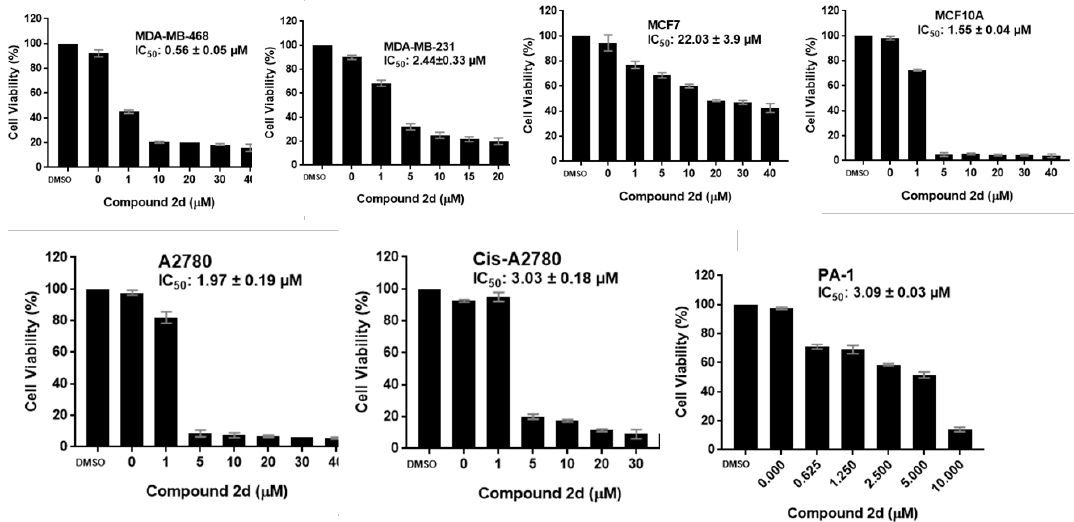
Figure 7. The cell viability (%) relative to untreated control cells of selected breast and ovarian cancer cell lines and breast normal (MCF10 A) cell line following the exposure of various concentrations of compound 2d for 48 h.